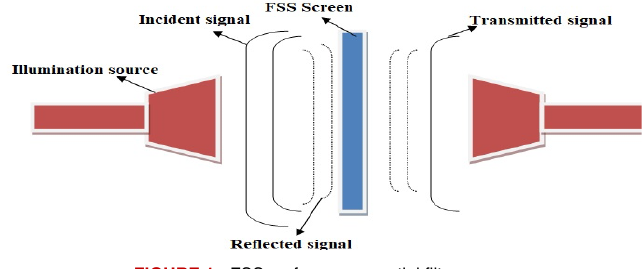
FIGURE 1: . FSS surface as a spatial